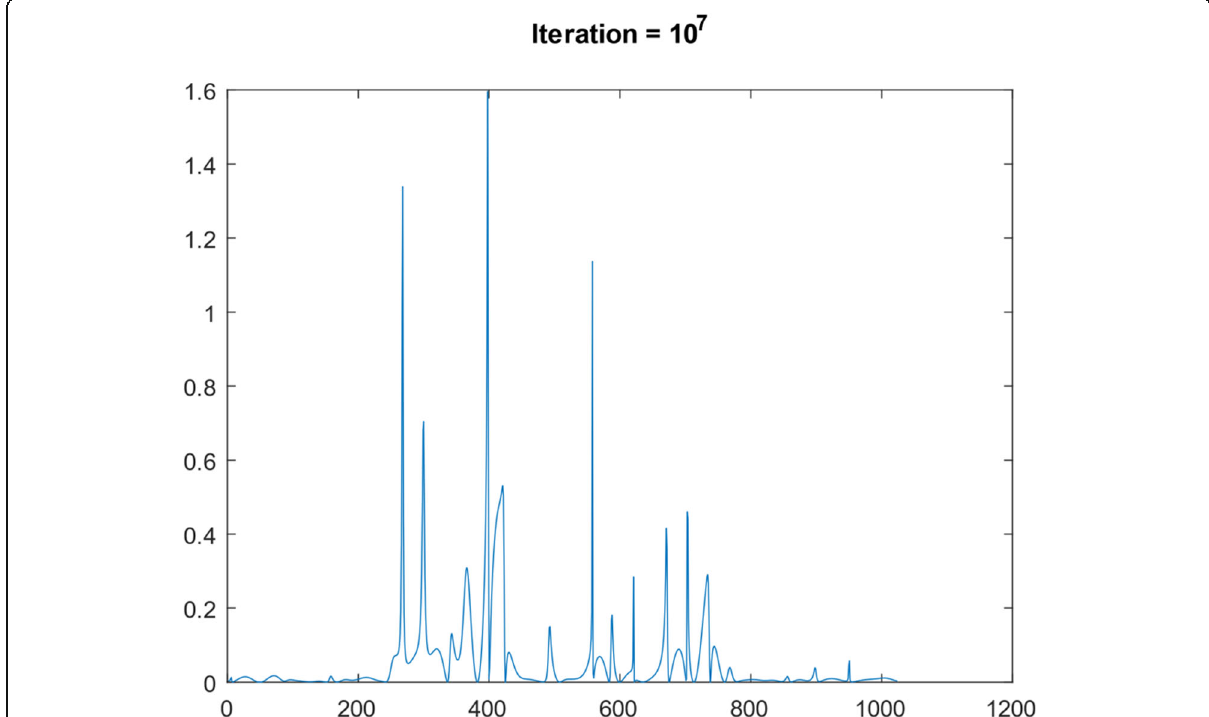
Fig. 9 Restored the ‘ random ’ function after 10 7 iteration of suggested algorithm using noisy data